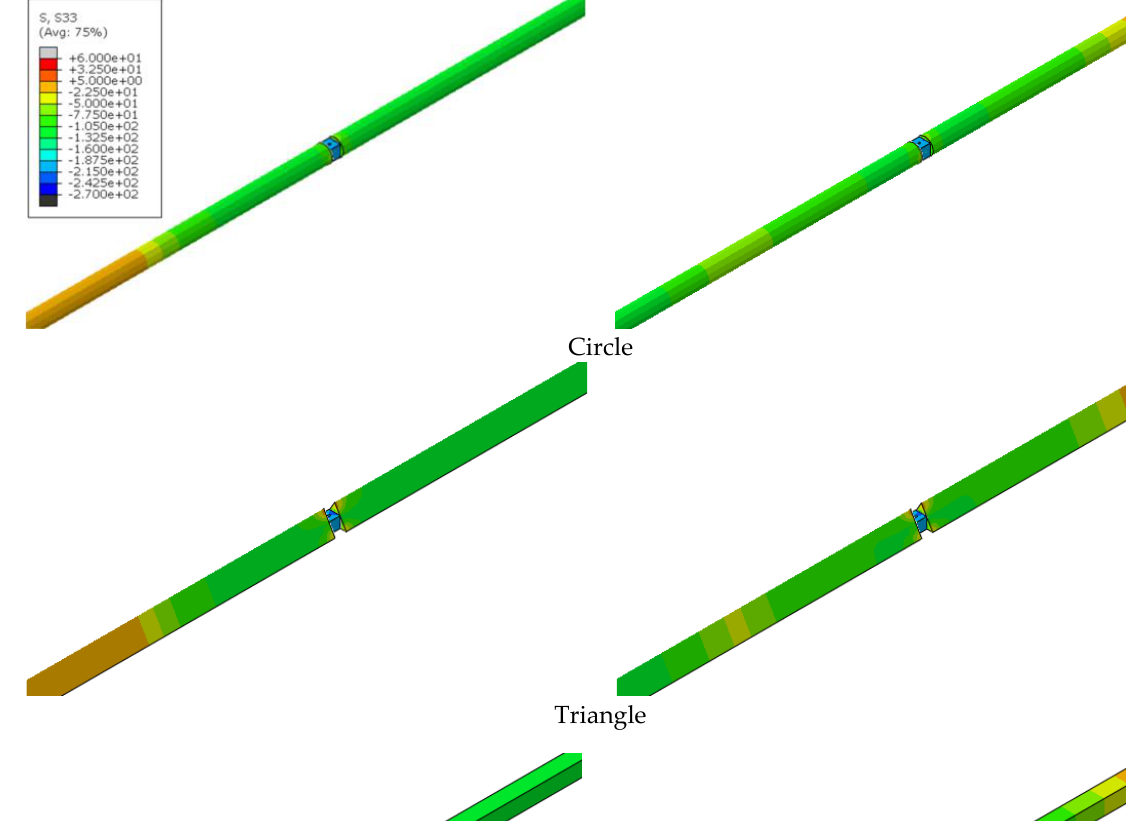
Figure 7. State of Von Mises stresses at two increments of time. ( a ) t = 0.6 ms and ( b ) t = 0.7 ms.